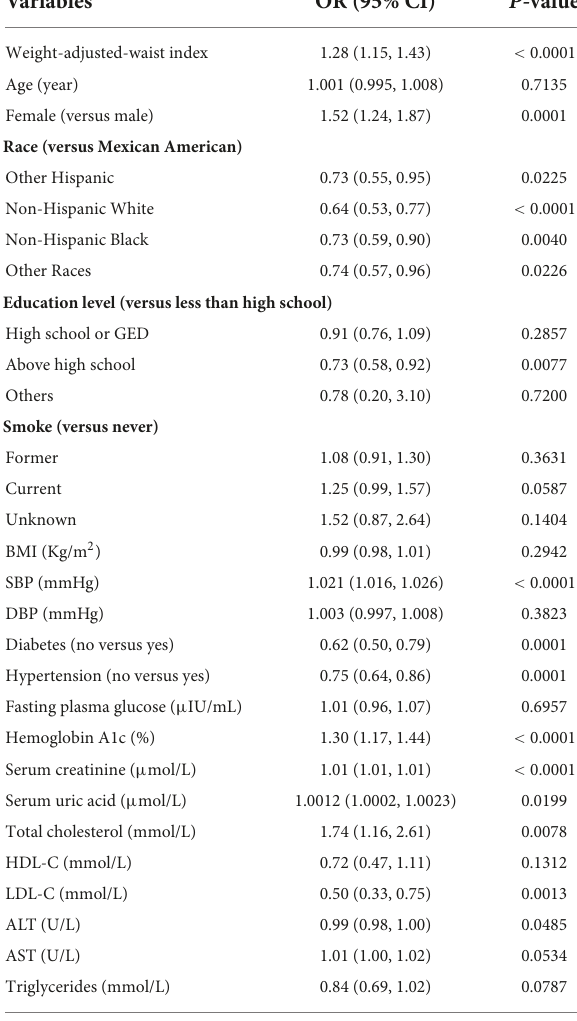
TABLE 2 Association between weight-adjusted-waist index and albuminuria.